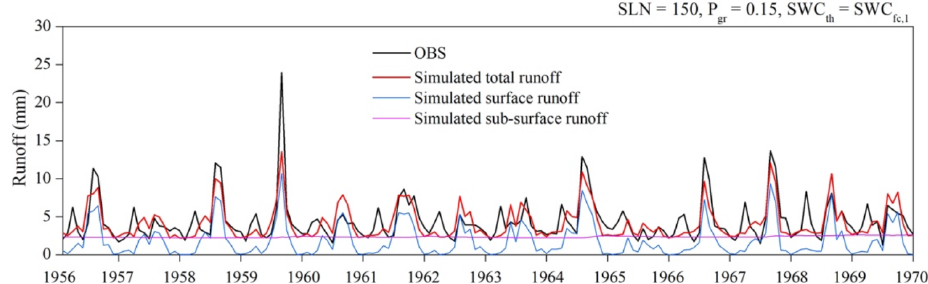
Figure 8. Time series of observed monthly runoff (black line) for the BJC hydrological station and simulated monthly total (red line), surface (blue line), and subsurface runoff (pink